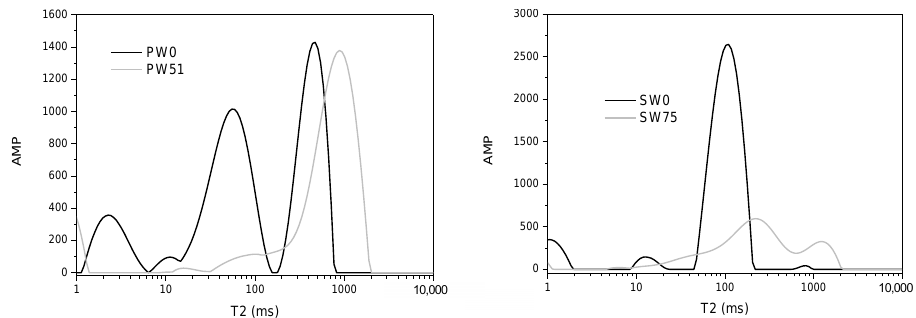
Figure 5. The T2 value distribution of fully water-saturated furfurylated and control Chinese fir and poplar wood.